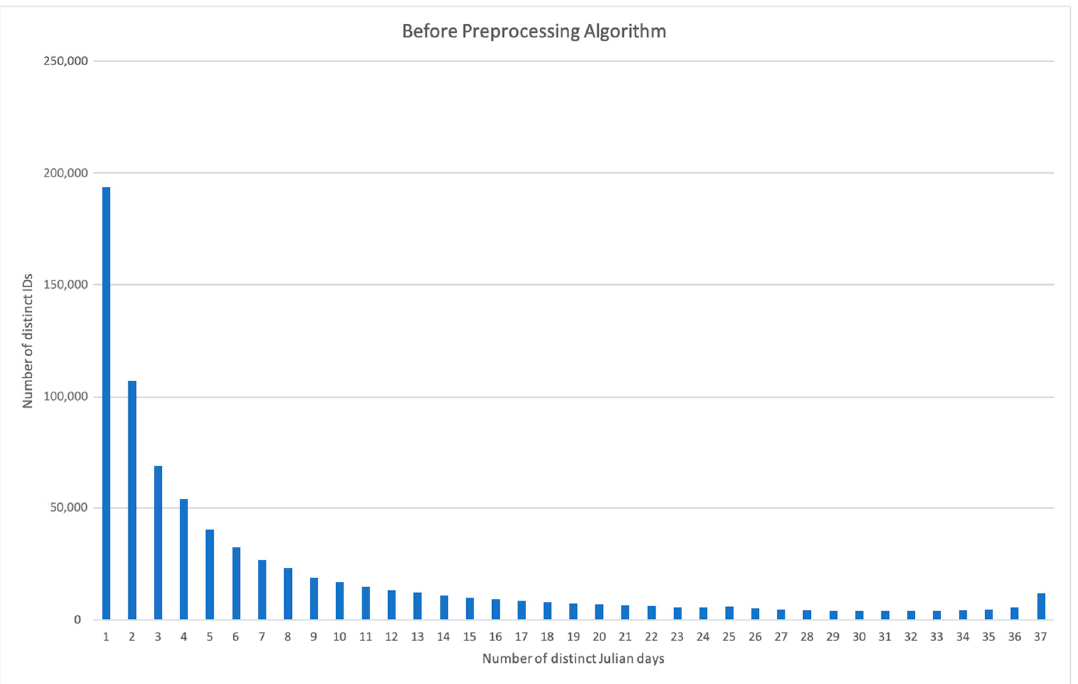
Figure 6. The distribution of unique IDs and the number of days that they were recorded as being present in the database.